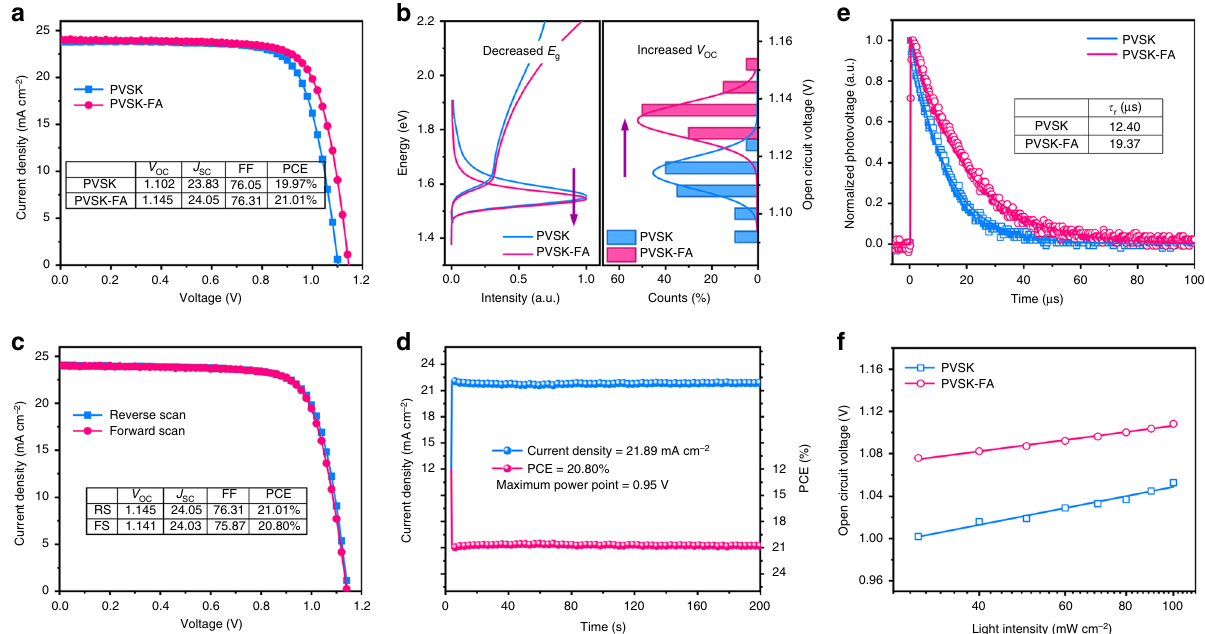
Fig. 5 Photovoltaic device performance. a Current density – voltage curves for PVSK and PVSK – FA devices. b Left part: the UV-vis and PL spectra of for the PVSK and PVSK – FA fi lms. Right part: the histogram of V OC for the PVSK and PVSK – FA devices and the curve represents Gaussian function fi t to the statistics data. c The champion device performance under reverse scan (1.2 to – 0.1 V) and forward scan ( – 0.1 to 1.2 V), with a scan rate of 40 mV s – 1 . d Steady-state current density and power conversion ef fi ciency holding the voltage at the maximum power point (0.95 V) for the PVSK – FA device.